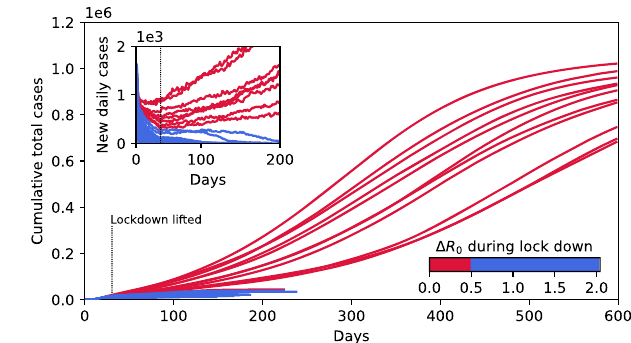
Fig. 4 Discontinuous nature of lockdown scenarios. Cumulative total number of cases for R 0 = 2 starting from 10 4 infectious agents in a population P = 3162 × 3162 ≈ 10 7 and subjected to gradually stronger lockdowns. Mitigation measures are simulated by a reduction in the basic reproduction number in the range of 0 < Δ R 0 < 2.0. The duration is 30 days in all scenarios. Testing here is limited to N T = 1000 individuals per day. Mild interventions (0 < Δ R 0 < 0.5, red curves) only result in an initial drop (see inset) in daily new cases but ultimately cannot prevent a subsequent rise in numbers and eventually a high proportion of the population becomes infected. Stronger interventions (0.5 < Δ R 0 < 2, blue curves) on the other